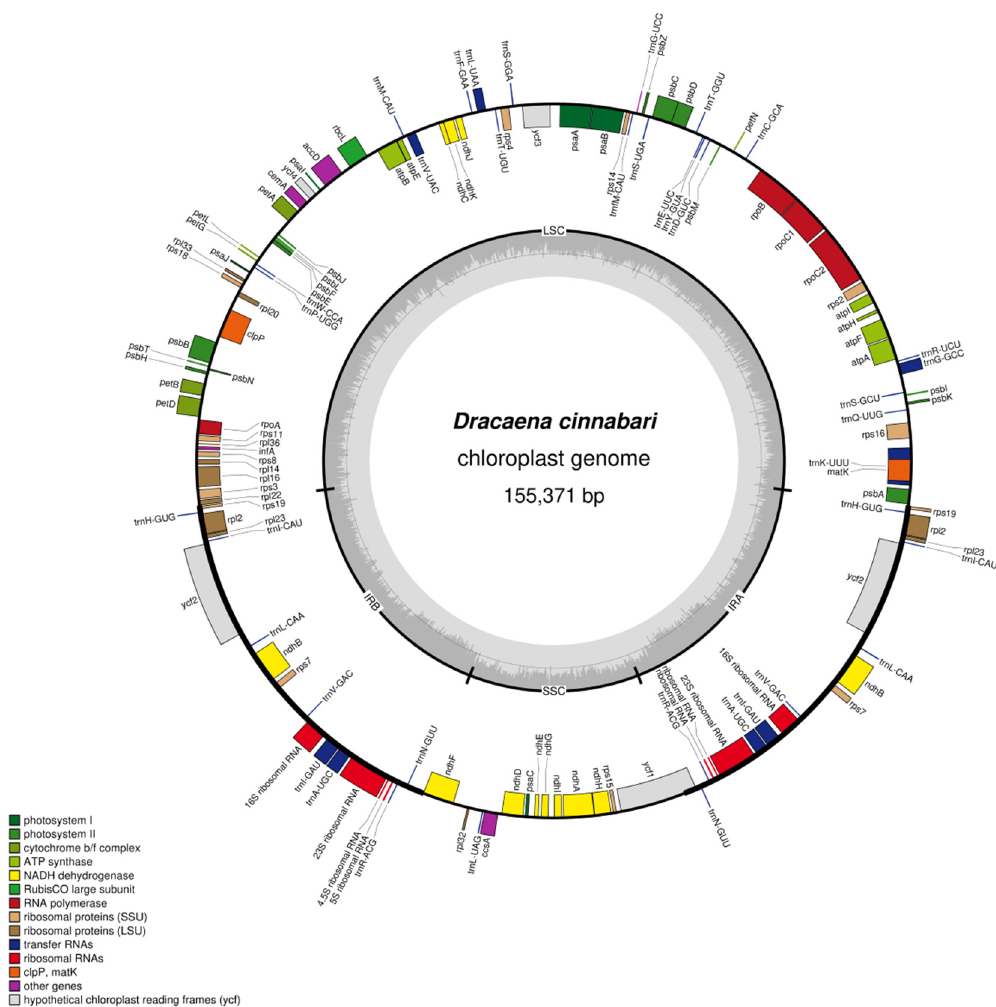
Figure 1. Gene map of the Dracaena cinnabari chloroplast genome. The genes inside the circle are transcribed clockwise, while those on the outside are transcribed counterclockwise. Genes belonging to different functional groups are color-coded. The darker gray in the inner circle shows the GC content, while the lighter gray corresponds to the AT content. IRA, IRB, inverted repeats; LSC, large single-copy region; SSC, small single-copy region. Table 1. Comparison of basic features of chloroplast genomes among four Dracaena species.